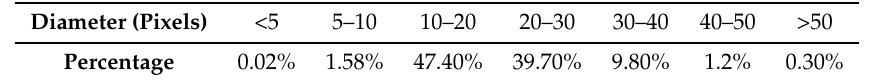
Table 1. Microaneurysm size